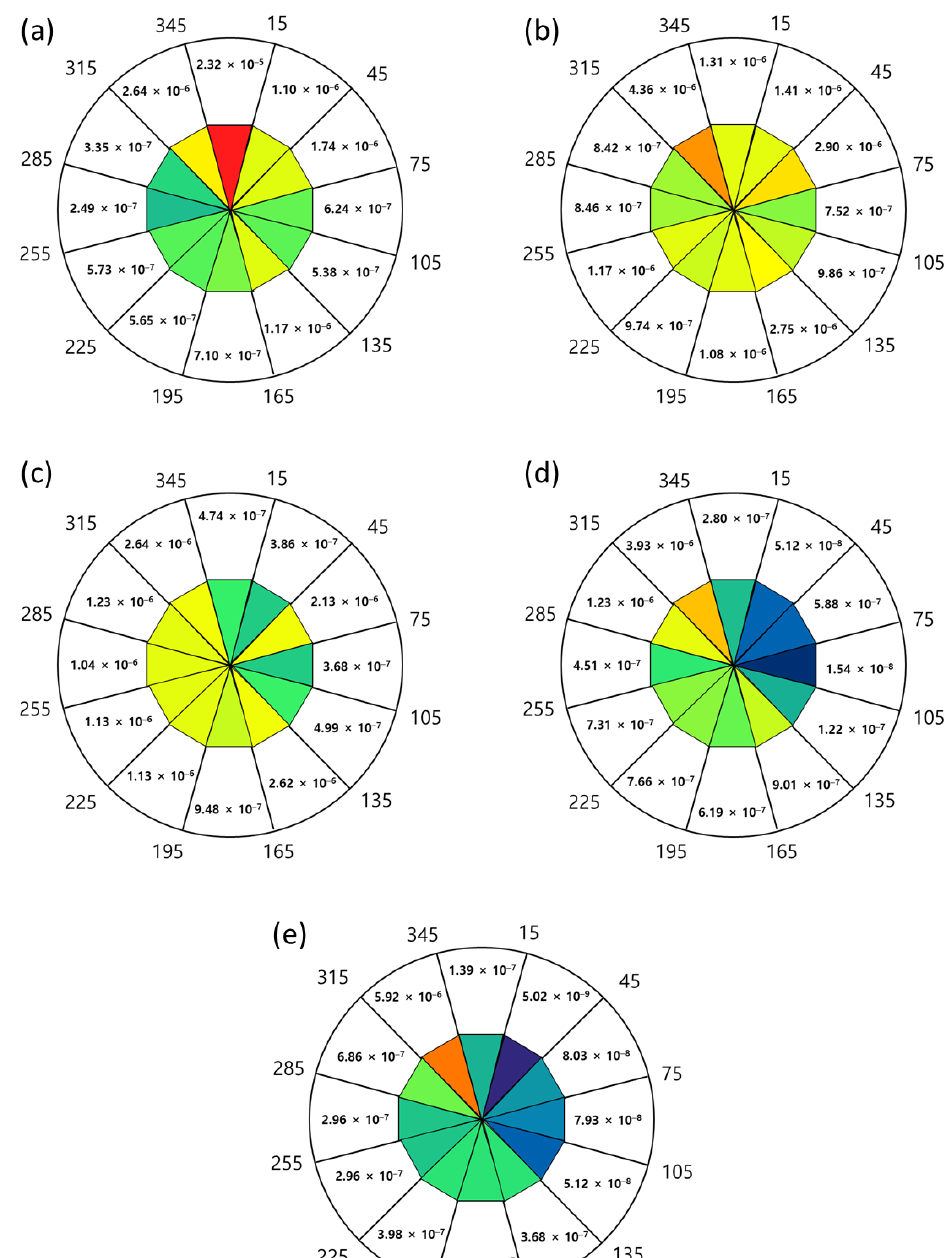
Figure 7. IR of 99% fatality at different wind directions and speeds: ( a ) 0–1 m/s, ( b ) 1–2 m/s, ( c ) 2–3 m/s, ( d ) 3–4 m/s, and ( e ) >4 m/s.